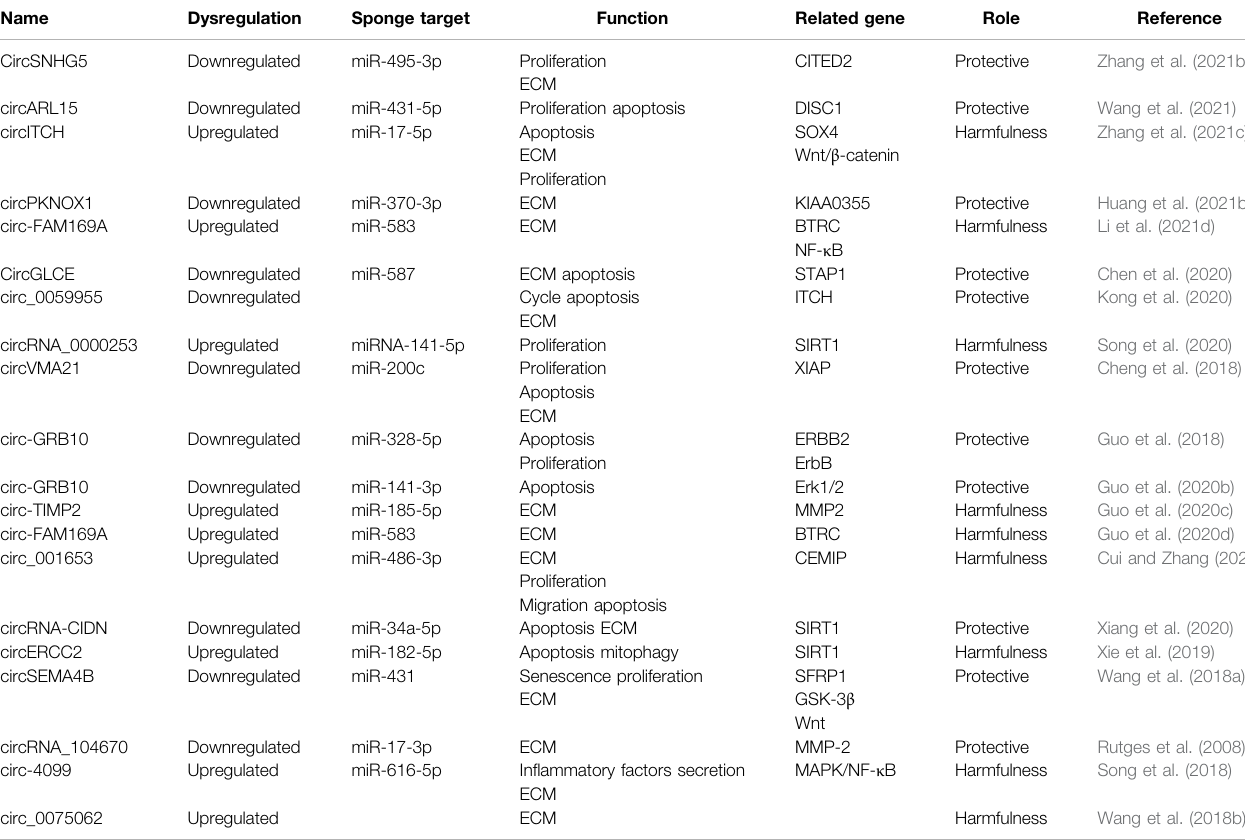
TABLE 1 | Dysregulated circRNAs in intervertebral disc